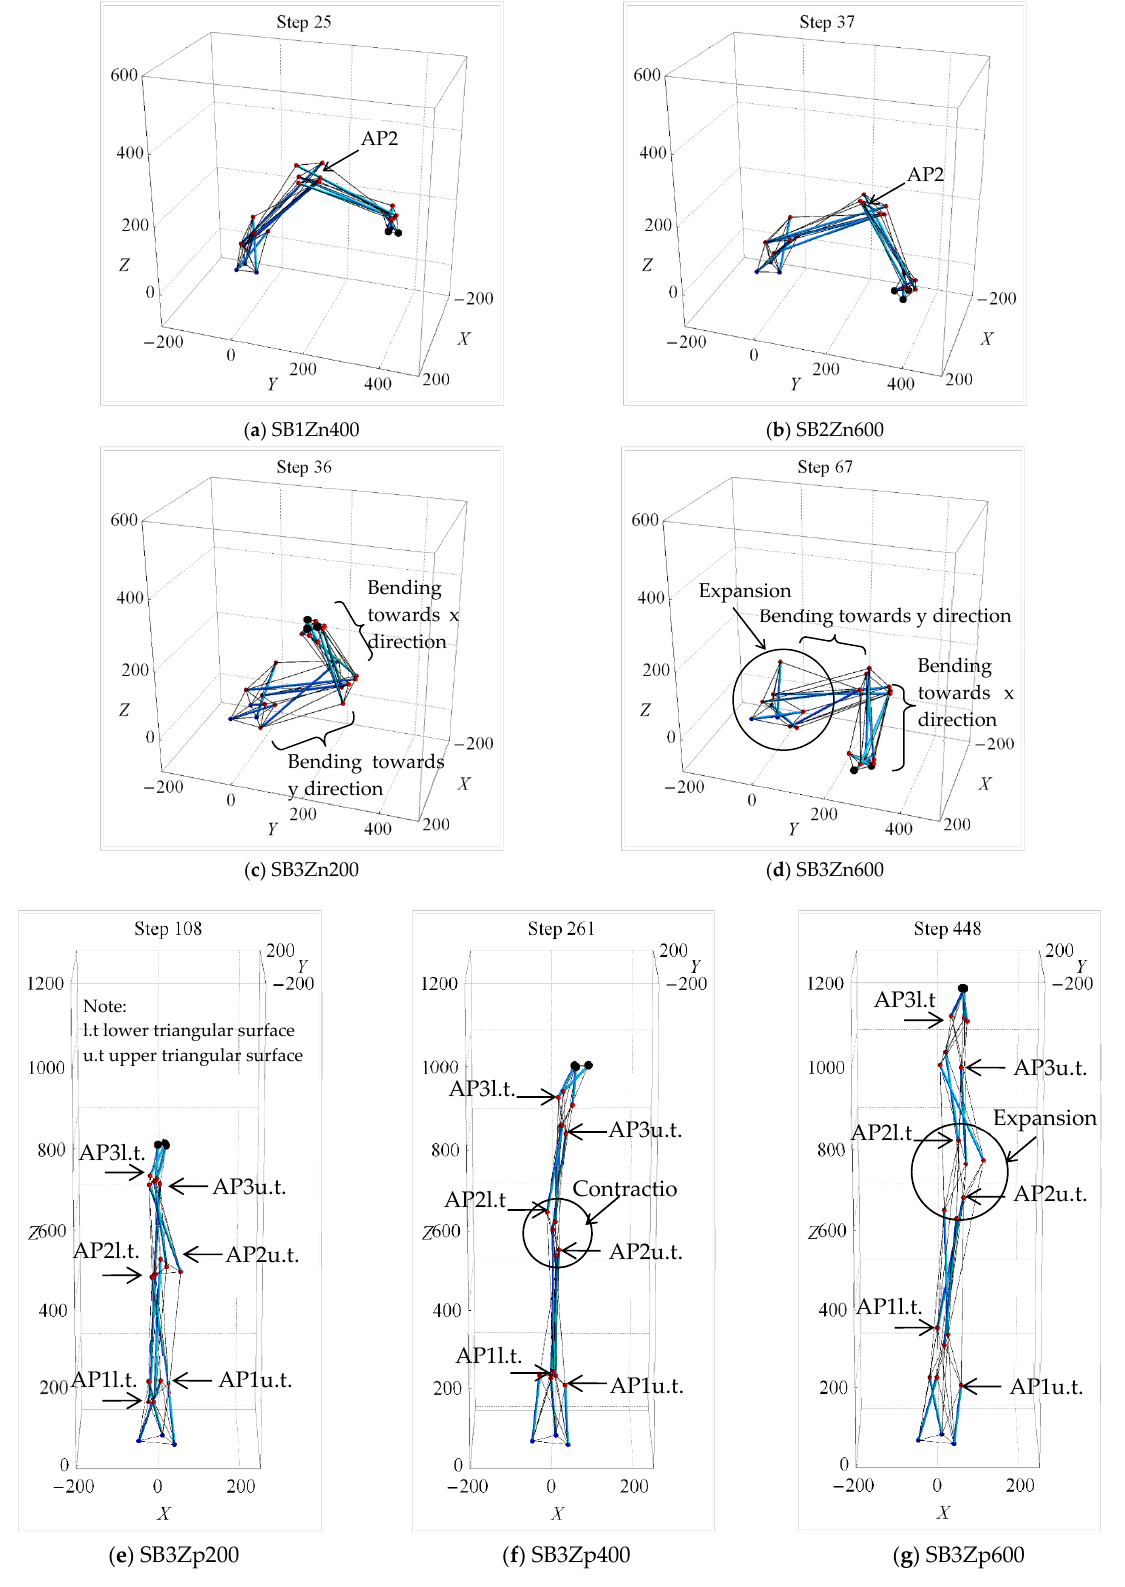
Figure 16. Deformed configuration ( a – g ) at the final step for cases with the uni-directional mode, series Zn and Zp.